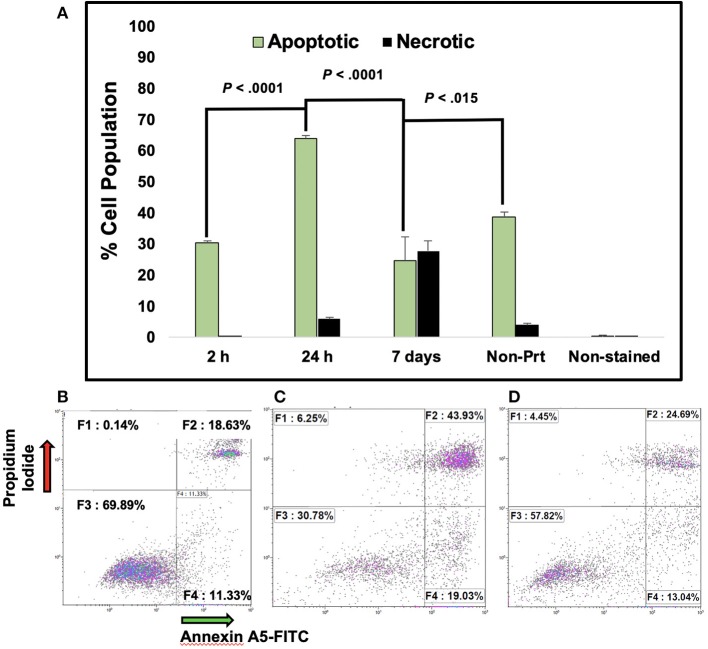
Percentage of Apoptotic MCF7 breast cancer cells post-bioprinting. The annexin A5-FITC kit was used for this analysis. Cells were collected post-bioprinting at 3 time frames, 2, 24 h, and 7 days Cells were BP in a modified HP thermal inkjet printer, onto a petri dish with EMEM, and the cells were incubated immediately. Graph (A) depicts the total percentage of apoptotic cell population is expressed as the sum of early and late apoptosis percentage (F2+F4), green bars. Dark bars depict necrotic cells, those are the cells stained with PI. Each bar represents the average of triplicates. Controls used were live cells stained, unstained, and dead cells (not shown). Error bars represent the standard deviations. (B) Dot plot graphs depict results at 2 h post-bioprinting. Graph (C) displays results at 24 h post-bioprinting. Graph (D) are the results from non-printed (manually seeded) MCF7s cells. P-values are from a two-tailed student t-test for independent tests (shown over the bars in A). 10,000 events were obtained per sample. The Kaluza Analysis v.1.3 software (Beckman Coulter) was used to extract the data and graphs.